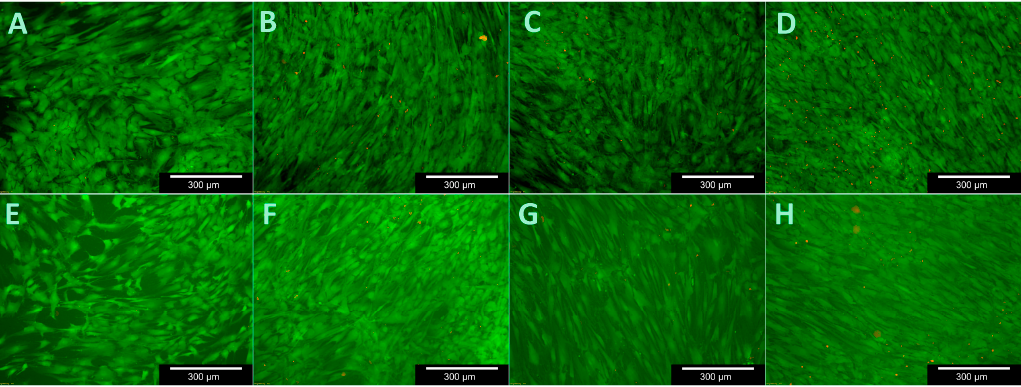
Figure 8. Live/dead assay: Cell number/mm² (living cells and dead cells) of human osteoblasts ( a ) and of MG 63 cells ( b ) on the C/SiSiC samples. Significance set at p < 0.05 are assigned the same symbol *. Materials 2018 , 11 , x FOR PEER REVIEW